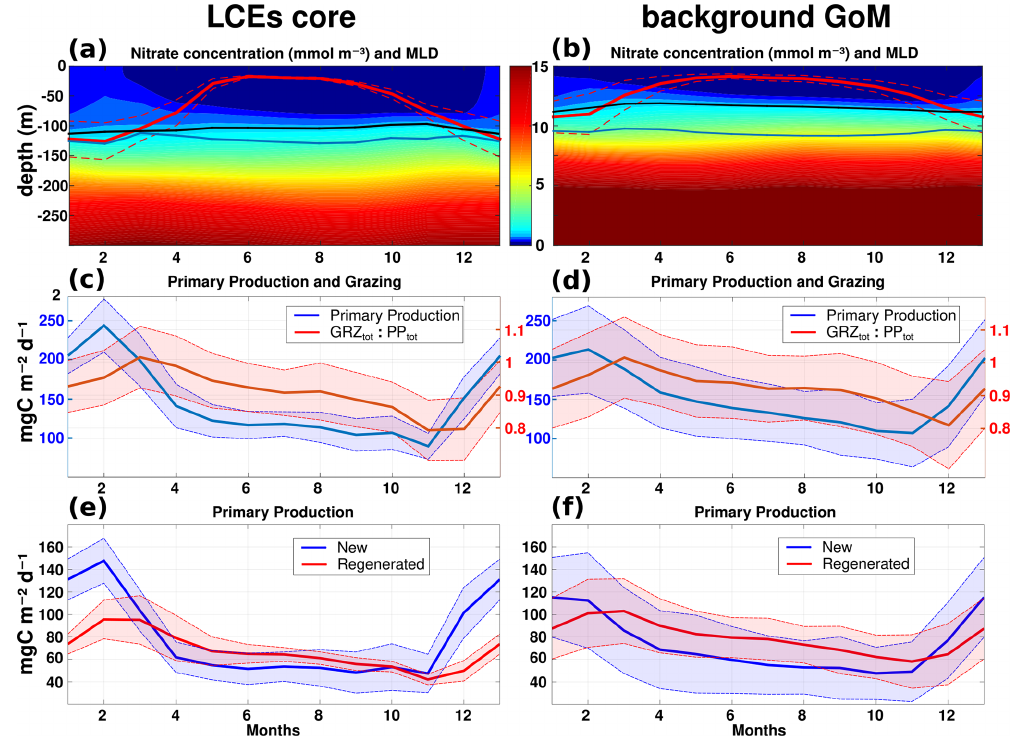
Figure 9. Climatological seasonal cycles of (a, b) nitrate concentration profiles (the red line overlaid is the average mixed layer depth, the blue line is the base of the euphotic layer, and the black line is the nitracline), (c, d) the total primary production (blue) and the ratio of grazing rate over primary production (red), and (e, f) the new (blue) and regenerated (red) primary production. Panels (a, c, e) refer to the seasonal time series in the LCE core ( r < 50km), whereas the right panels (b, d, f) refer to the seasonal time series in the background GoM ( r > 200km). For each average cycle, the mean value is shown (full line) along with its variability ( ± 1 standard deviation relative to the mean, dashed